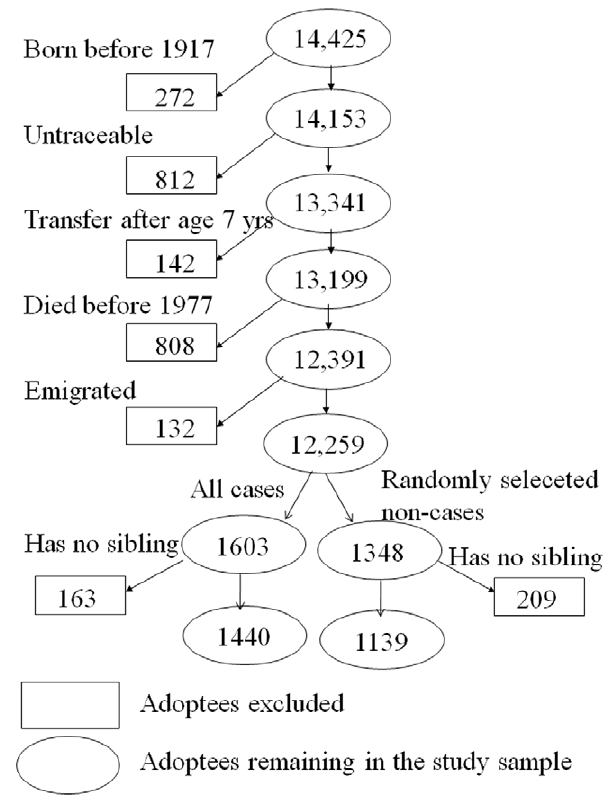
Figure 1. Flow chart illustrating the number of adoptees in the study